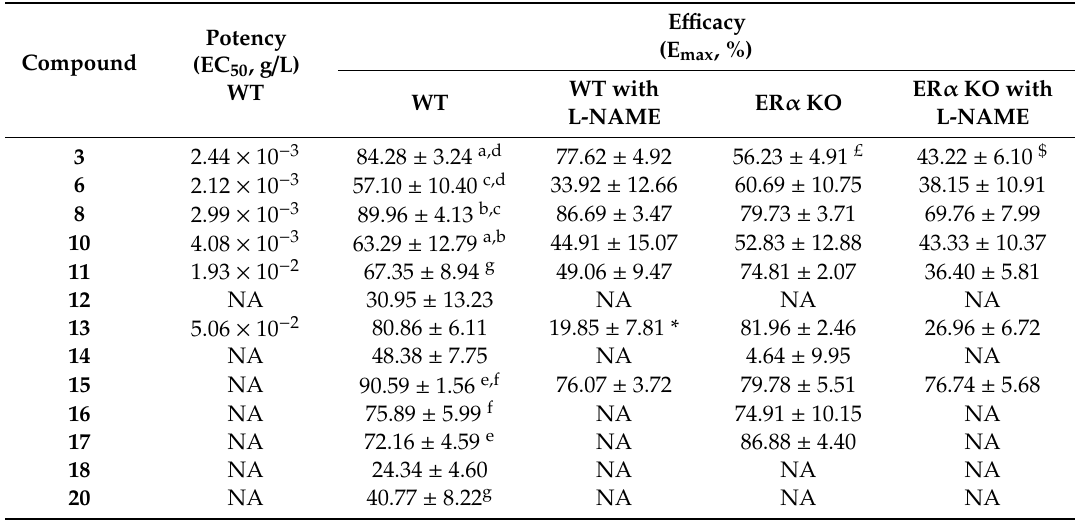
Table 2. Summary of the potency and e ffi cacy of